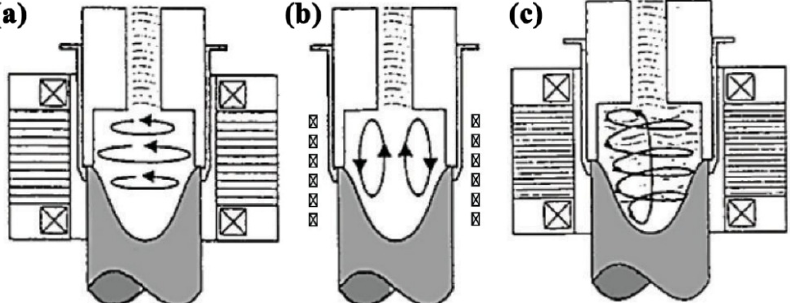
Figure 7. Schematic diagram of different flow modes system ( a ) horizontal agitation; ( b ) vertical agitation; ( c ) helical agitation [108]. Reprinted under the Creative Commons Attribution License (CC-BY) 4.0.